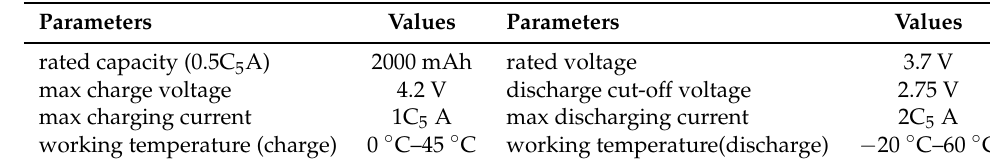
Figure 5. Experiment setup. Table 2. LIB 18650 cell parameters.